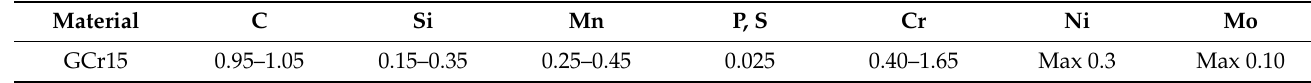
Table 1. The chemical composition of GCr15 (wt